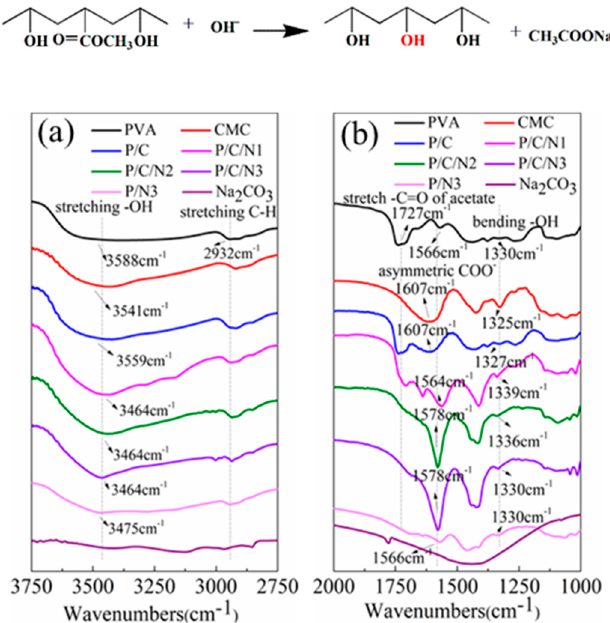
Figure 2. FTIR spectra of Na 2 CO 3 and the obtained composite films: ( a ) region from 3750 cm − 1 to 2750 cm − 1 ; ( b ) region from 2000 cm − 1 to 1000 cm − 1.